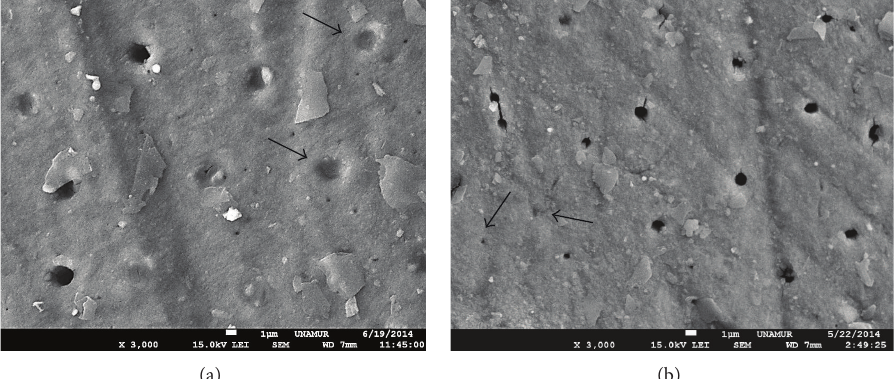
Figure 3: SEM view of Nd:YAP lased dentin treated previously with EDTA (18%). SEM view of exposed dentine with Nd:YAP laser beam at